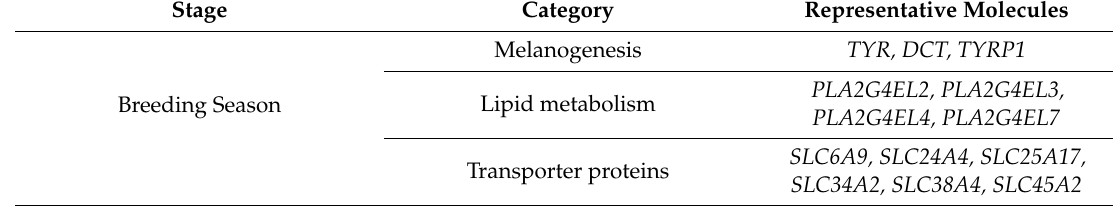
Table 2. Partial upregulated DEGs in breeding and nonbreeding season